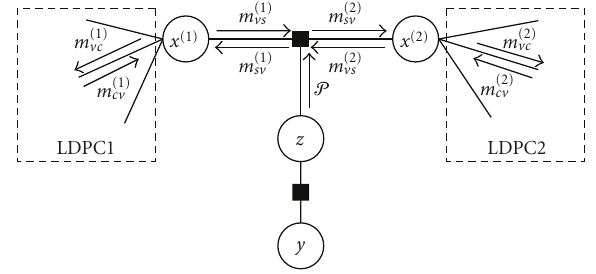
Figure 1: Factor graph of the 2-user synchronous MAC channel: zoom around the state-check node